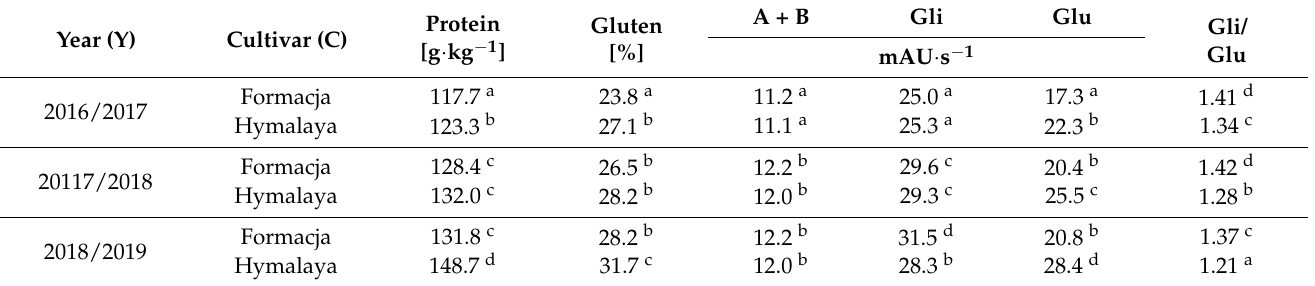
Table 6. Effect of cultivars and years of research on the content and composition of